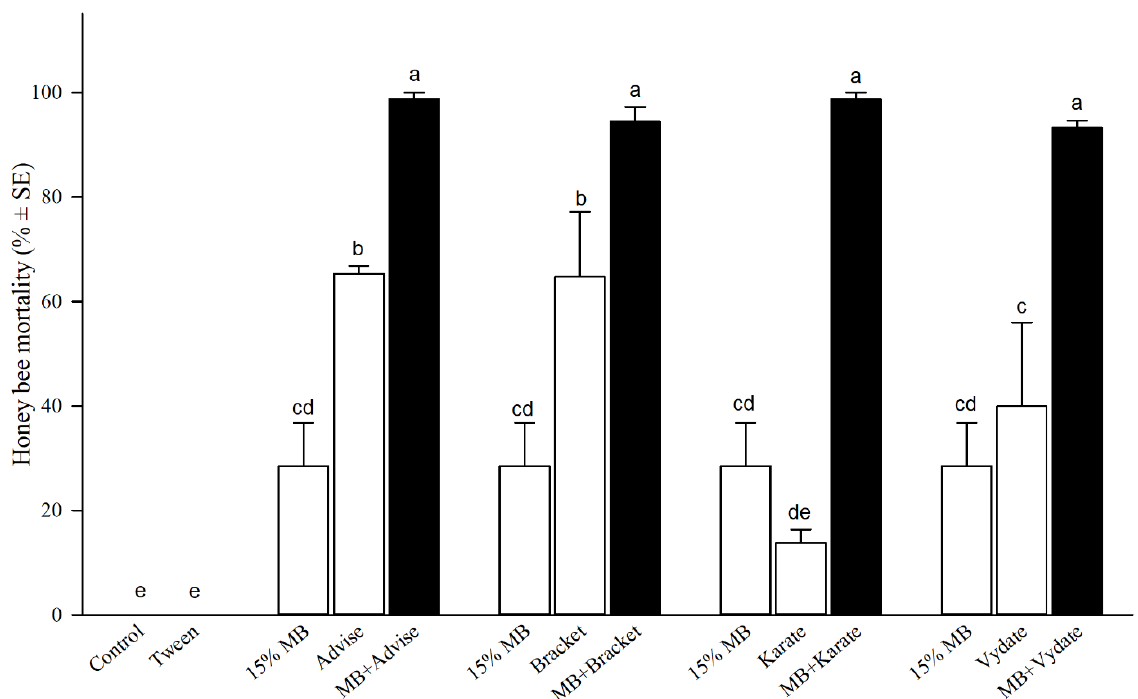
Figure 2. Synergistic spray toxicity of methyl benzoate (MB at 15%) mixed with four representative insecticides (classes), imidacloprid (Advise ® at 357 mg/L), acephate (Bracket ® at 103 mg/L), lambda-cyhalothrin (Karate ® at 362 mg/L), and oxamyl (Vydate ® at 180 mg/L) in honey bees. Mean bars with same letters at the top of error bars indicate no significant difference between treatments ( p > 0.05). The treatment of 15% MB was reused for side-by-side graphical comparison within each of four insecticide groups.